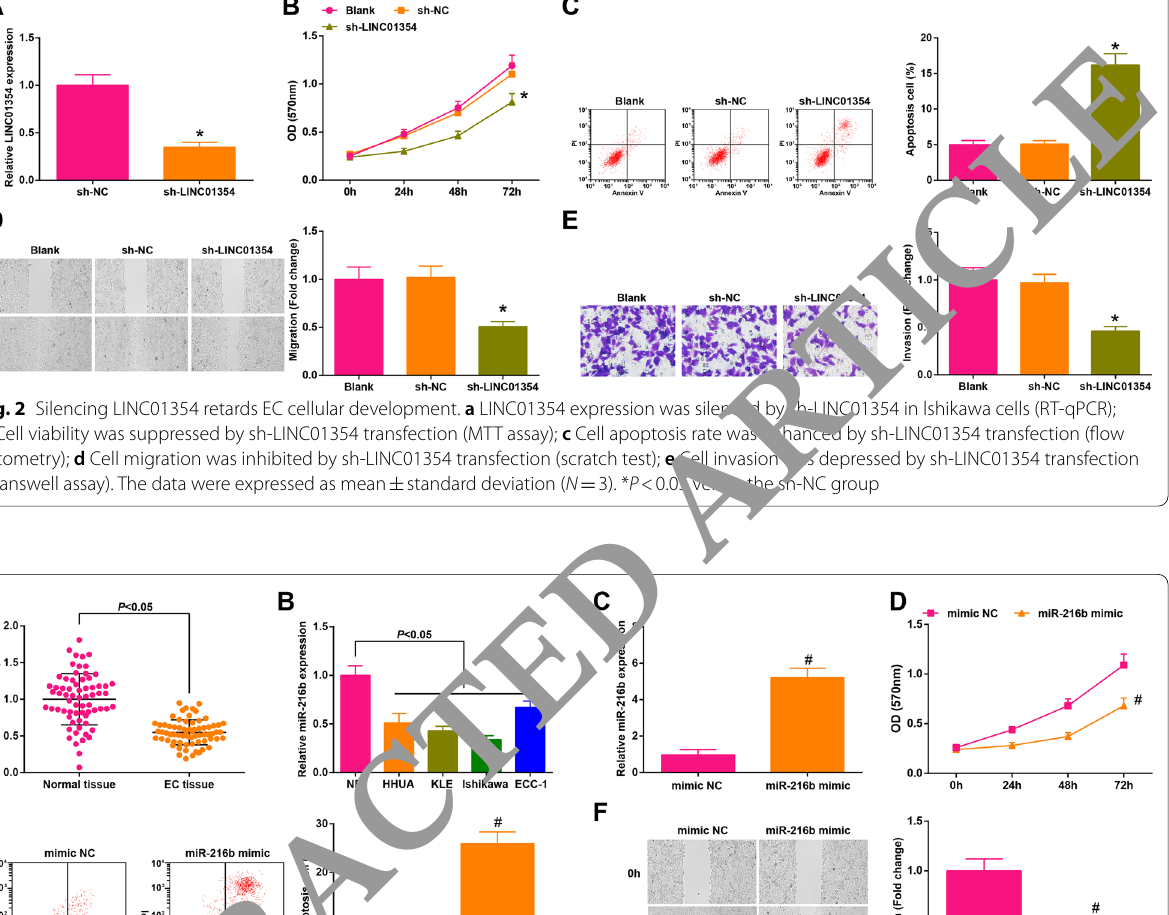
were co-transfected into lshikawa cells. Then, assays revealed that miR-216b inhibition could negate depleted sion (Fig. 5a), as well as on lshikawa cell development (Fig. 5b–e). In brief, LINC01354/miR-216b/KRAS axis regulated EC cell fate.